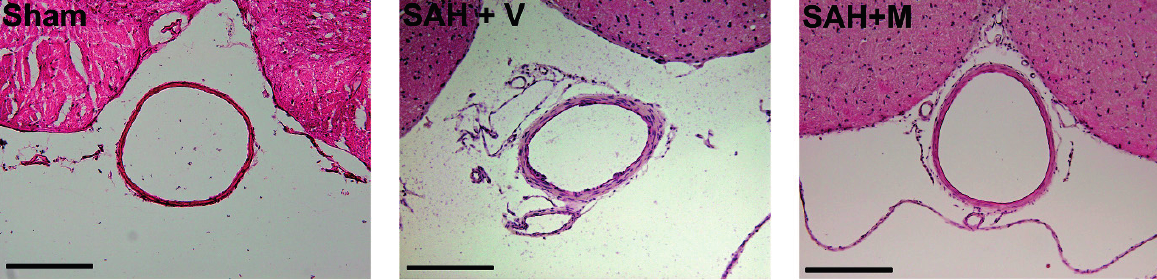
Figure 1. Subarachnoid hemorrhage (SAH) induced delayed vasospasm. Photographs of